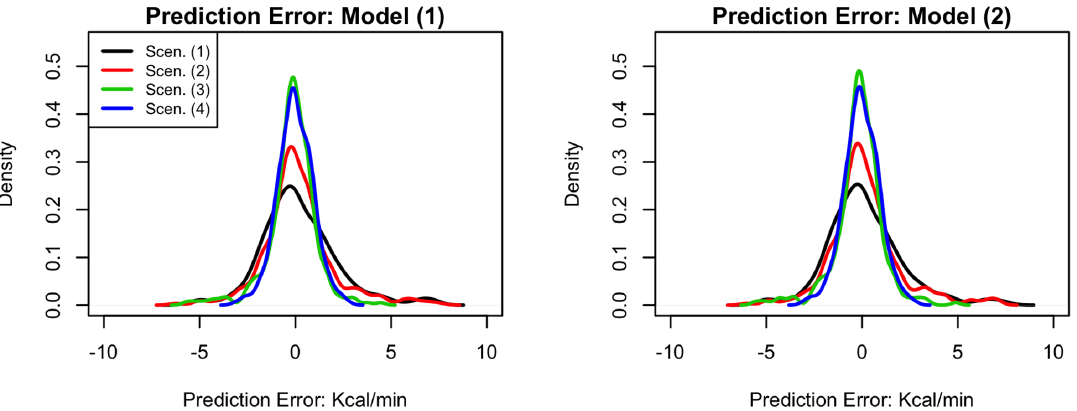
Figure 2. Figure 2 shows Kernel density estimates for the distribution of prediction errors for the four calibration data scenarios considered: (1) no calibration data, (2) resting heart rate and energy expenditure, (3) resting and peak heart rates and energy expenditures, and (4) all five levels of heart rate and energy expenditure. The left panel shows prediction errors computed under model (1), which uses four age/gender categories to predict energy expenditure, and the right panel prediction errors computed under model (2), which uses gender and age as continuous variables, and their interaction to predict energy expenditure.